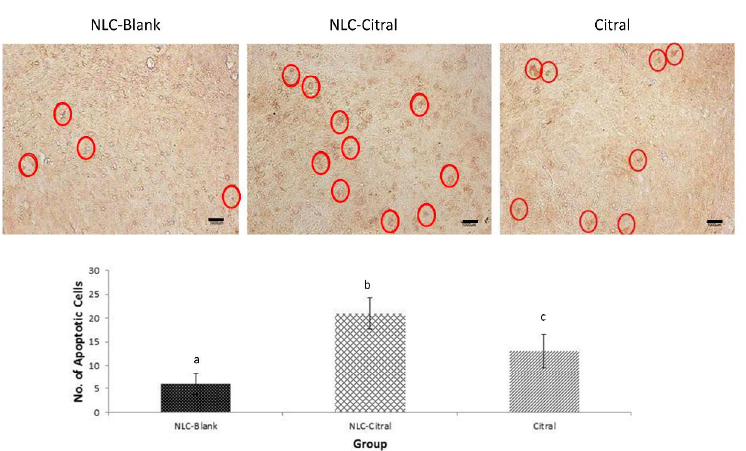
Figure 5. The representative images and histogram analysis of TUNEL assay of tumor from NLC-Blank, NLC-Citral, and citral groups. The red circle illustrates the DNA fragmentation detected in the tumor sections. The magnification viewed was at 100 × . The scale bar shows 100 µ m. Each value in the bar chart is represented as mean ± SD and the experiment was performed in triplicate. Significance indicated by different alphabet was set at p < 0.05 comparing between groups.